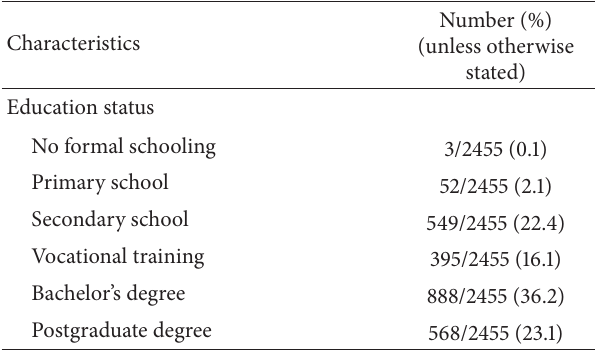
Table 3: Characteristics of the study sample.